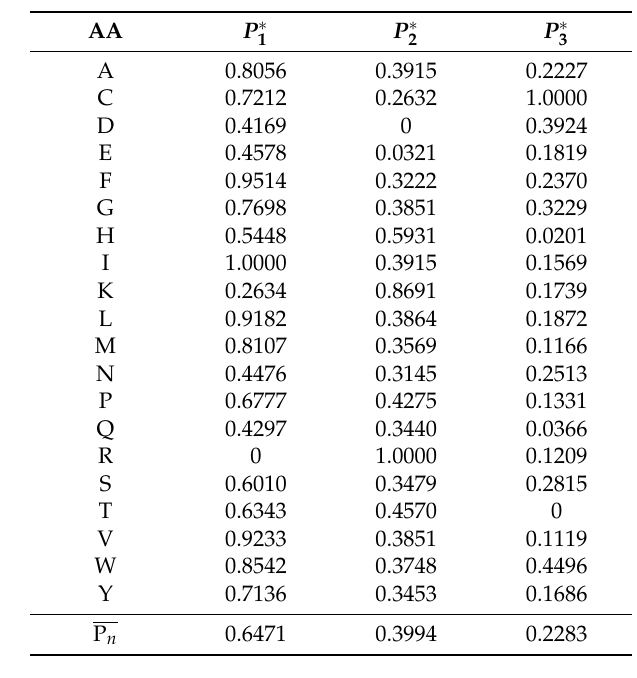
Table 2. The normalized values for the properties of the 20 native amino acids.